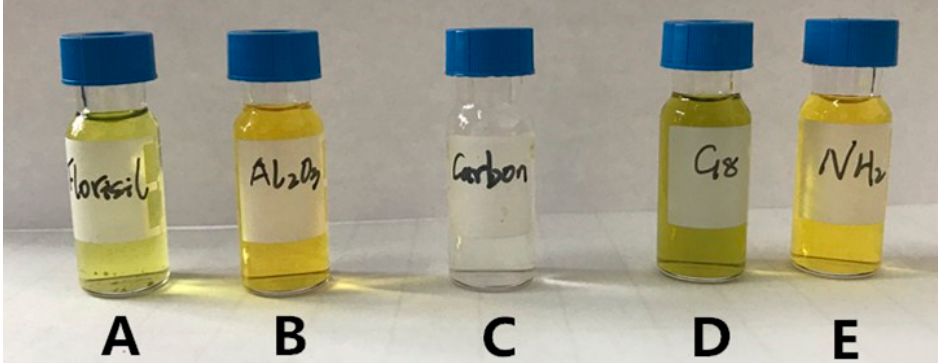
Figure 3. Colors of bok choy after treatment with different SPE purification columns (A: Florisil, B: Alumina-N, C: Carbon, D: C 18 , E: NH 2 ).